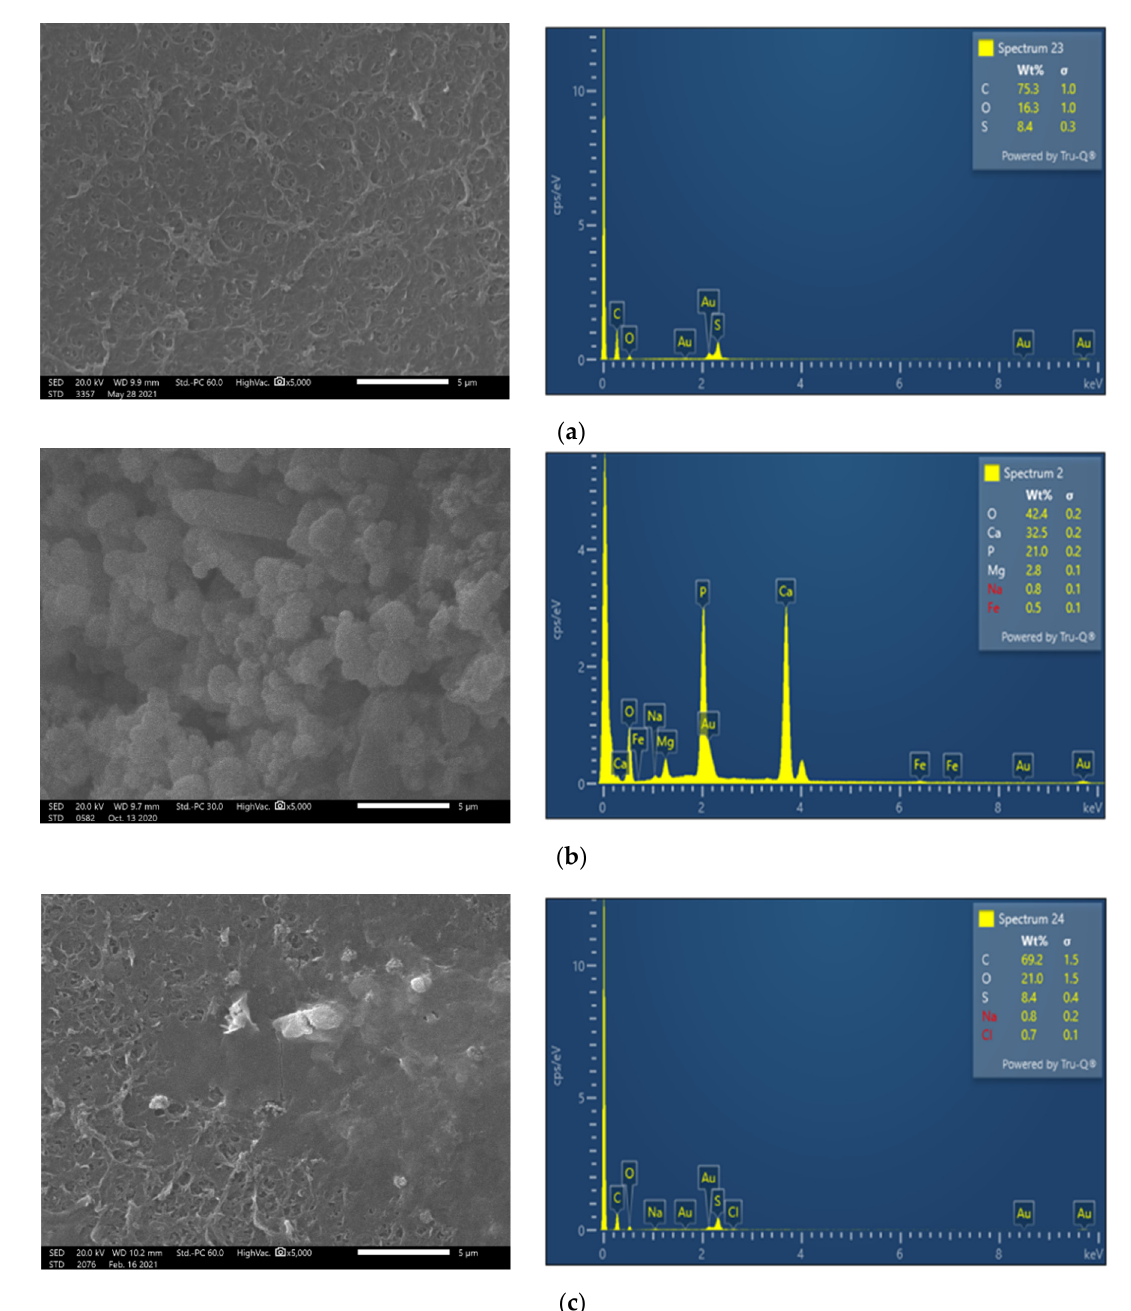
Figure 5. SEM images (×5000) and EDS spectrum of membrane surface. Comparison of ( a ) fresh NF90 membrane; ( b ) NF90 after the filtration of untreated FLD (test No 1P); and ( c ) after the filtration of pretreated FLD (test No 3P).